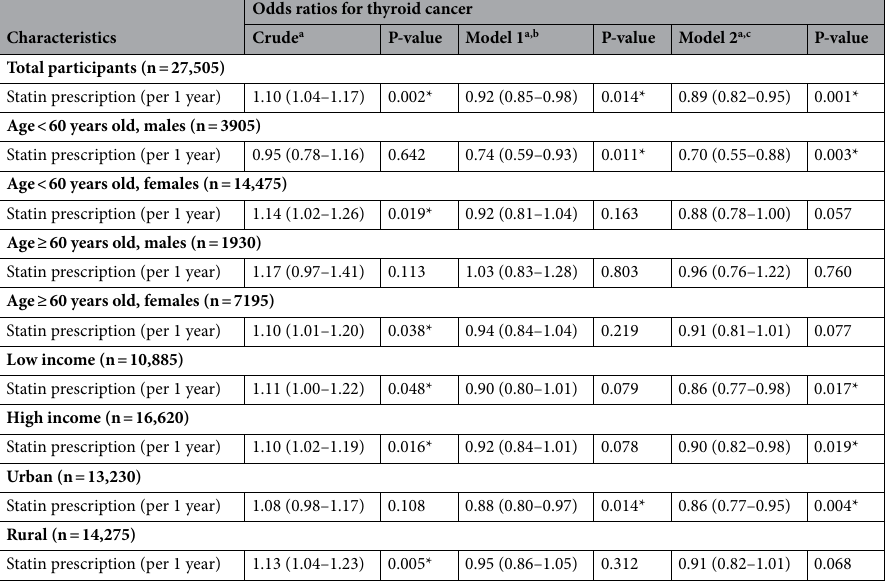
Table 2. Odds ratios (95% confidence interval) of the date of statin prescription (per 1 year) for thyroid cancer with subgroup analyses according to age, sex, income, and region of residence. CCI Charlson comorbidity index, DBP diastolic blood pressure, SBP systolic blood pressure. *Conditional logistic regression, significance at P < 0.05. a Models were stratified by age, sex, income, and region of residence. b Model 1 was adjusted for SBP, DBP, dyslipidemia history, total cholesterol and fasting blood glucose. c Model 2 was adjusted for model 1 plus CCI scores, smoking, alcohol consumption, and